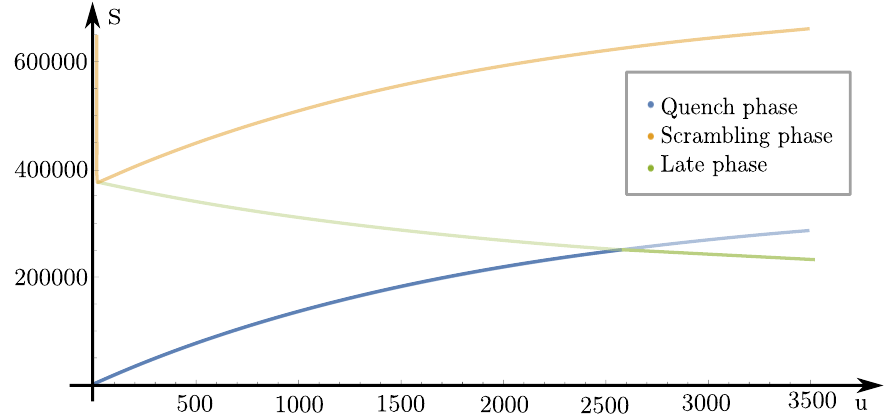
Figure 8. The generalized entropy of the three saddles for a semi-infinite segment of radiation in the bath. Under the condition that eq. (3.19) holds, the transition from the Quench phase to the Late phase happens around u island specified in eq. (3.20). This transition is a true island transition where an island forms in the Late phase. The parameters used for this figure can be found in table